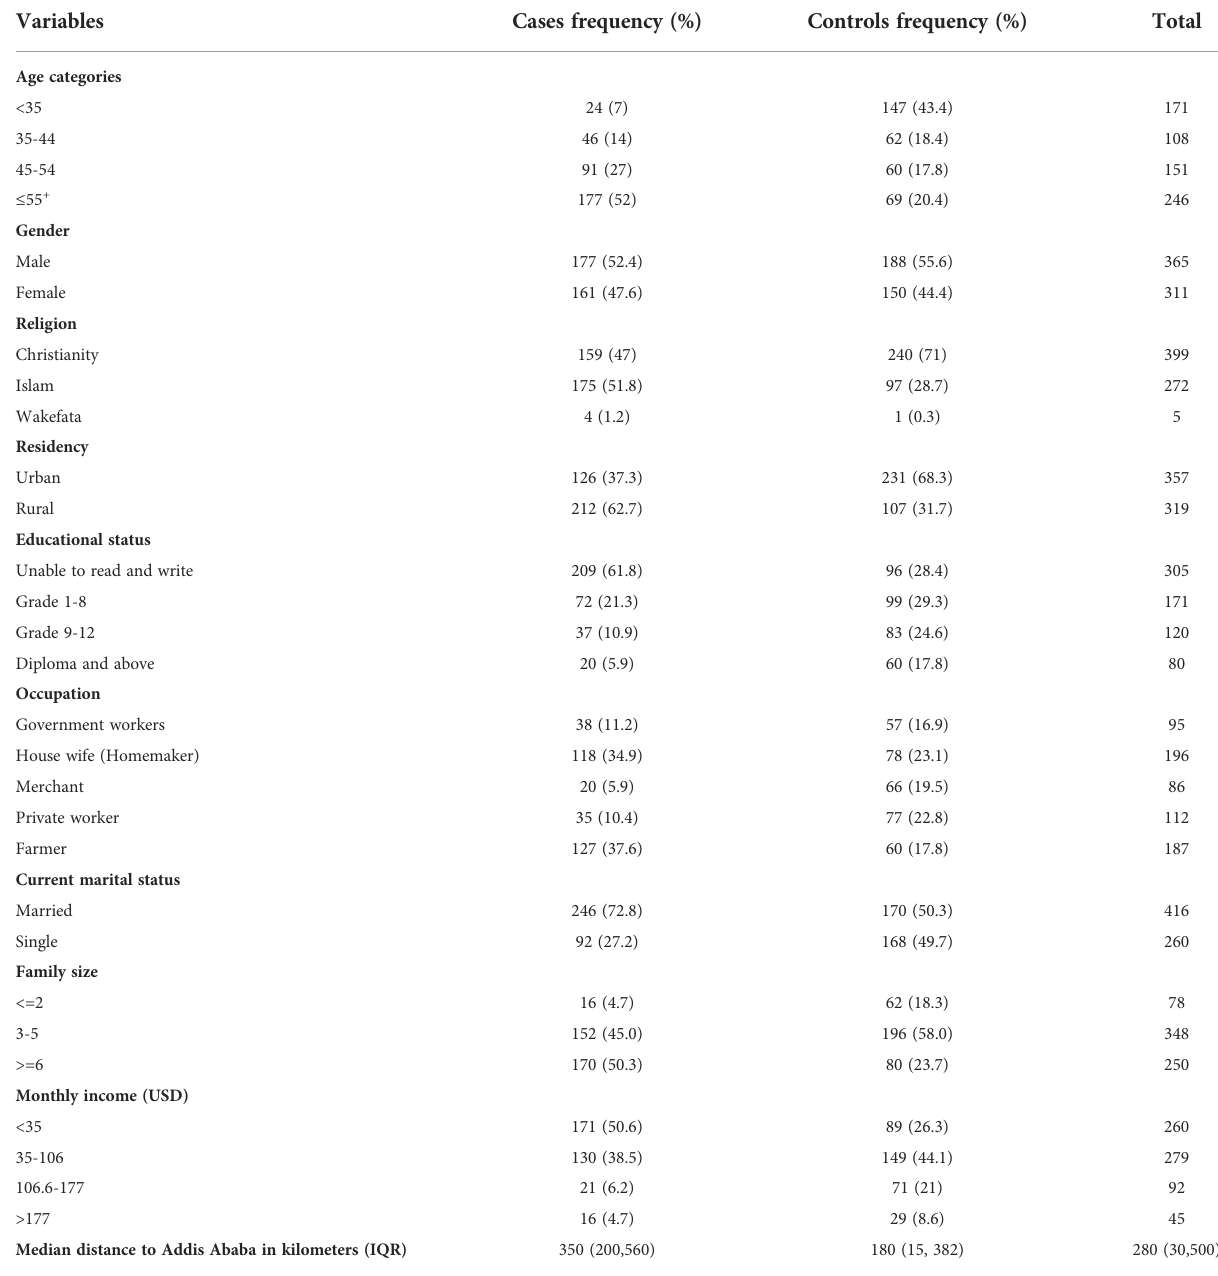
TABLE 1 Socio-demographic characteristics of cases and controls Addis Ababa, Ethiopia, from February 2019 to August